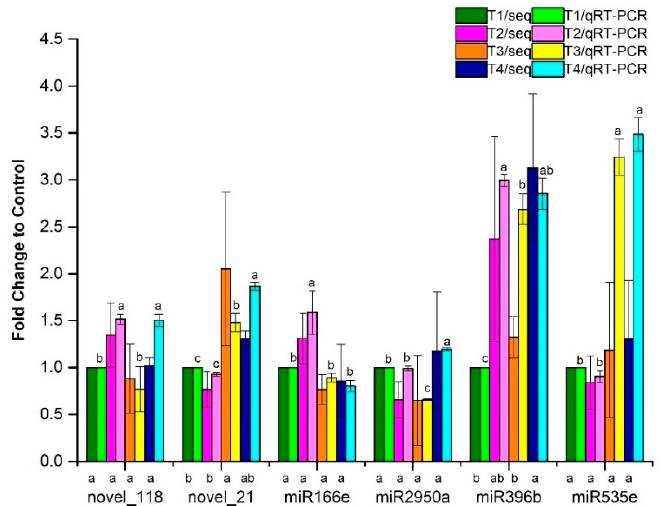
Figure 3. Validation of six miRNAs by qRT-PCR. T1-T4/seq indicated relative expression level of miRNAs calculated based on TPM and the significance was indicated below the bar chart, T1-T4/seq indicated relative expression level of miRNAs calculated based on 2 − ∆∆ Ct , and different lowercase letters indicating statistically significant difference were indicated above the bar chart.